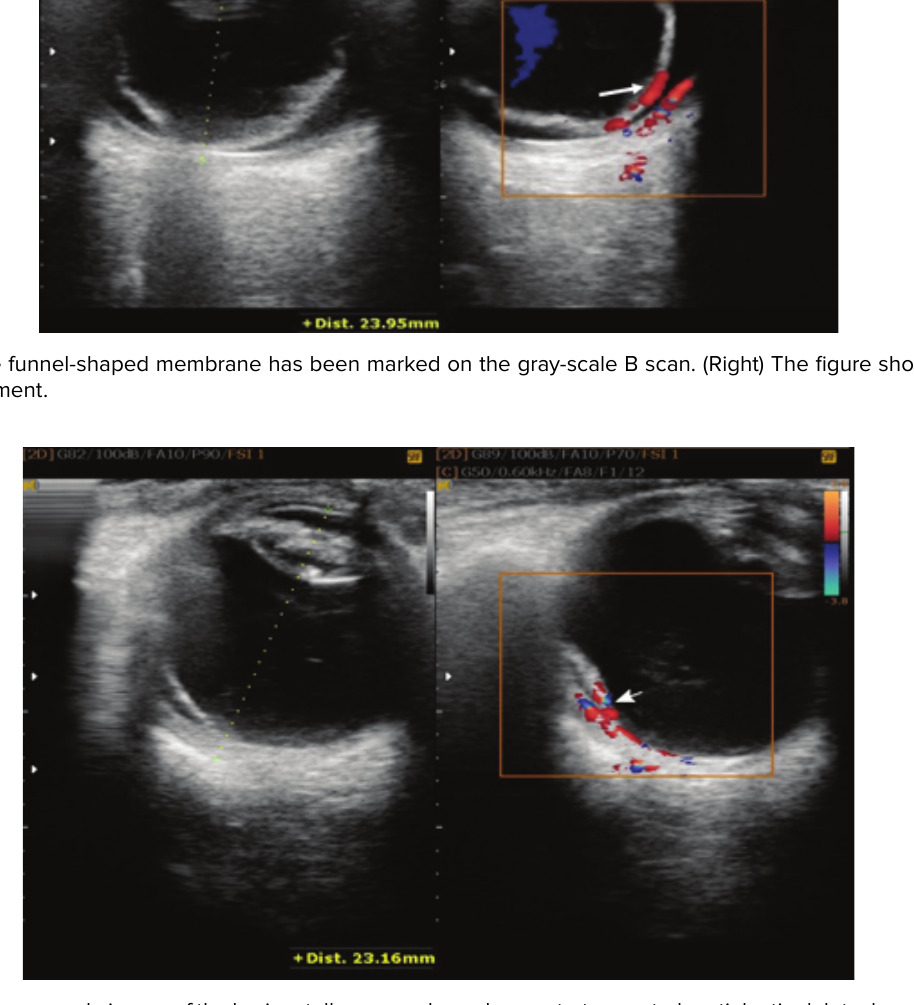
Figure 2. (Left) The gray-scale image of the horizontally scanned eye demonstrates central partial retinal detachment. (Right) Color Doppler ultrasound reveals thick linear and spotty color